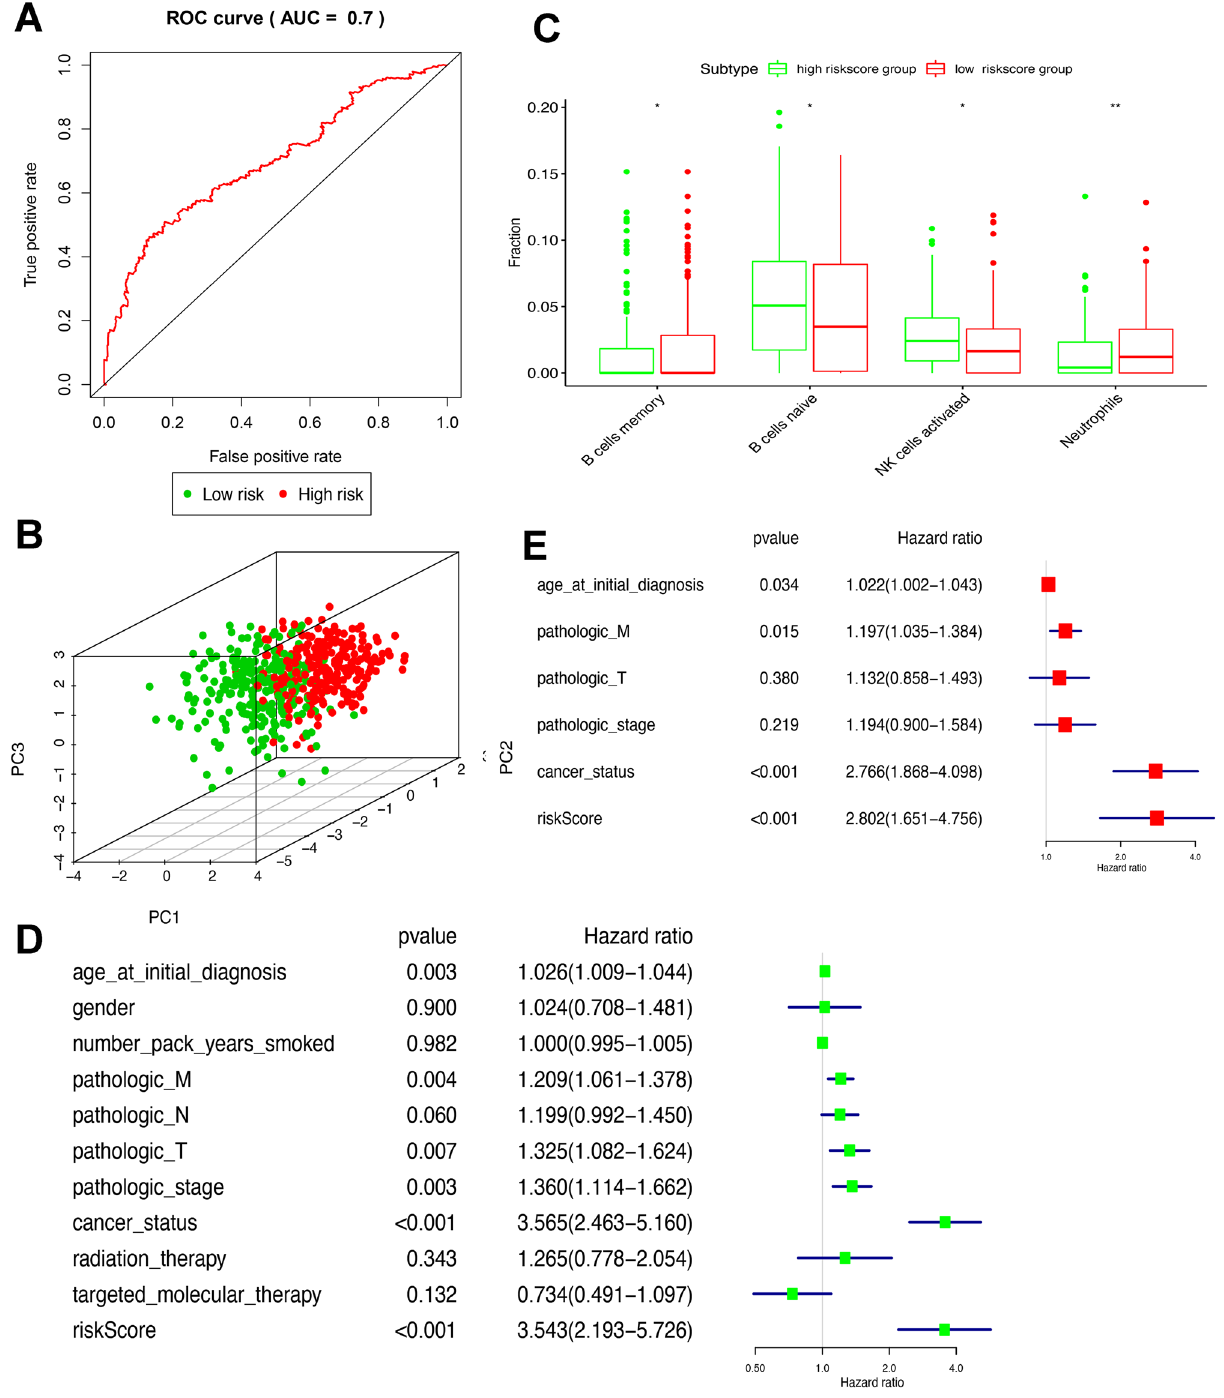
Figure 6. Validation of the signature ( A ) ROC curve analysis of the prognosis signature in TCGA dataset. ( B ) Principal component analysis. ( C ) Boxplot showed the ratio differentiation of 4 kinds of immune cells between high-risk score and low-risk score groups. DE Univariate and multivariate Cox regression analysis in LUSC. * p < 0.05, ** p <